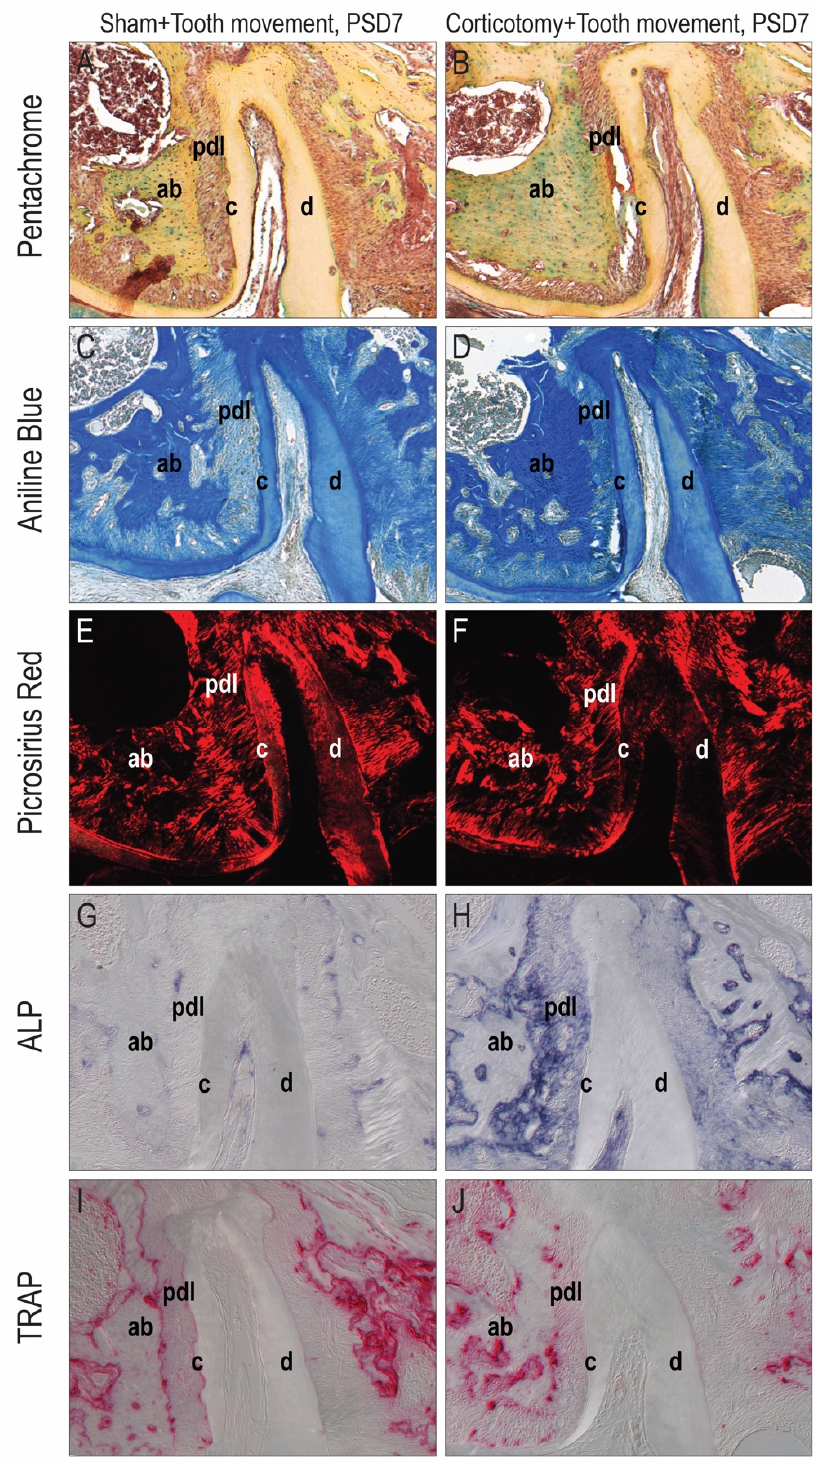
Figure 4. Histological sections from the distal roots of the maxillary first molar on PSD 7 ( n = 12). ( A ) Tissue sections stained with Movat’s pentachrome after Sham + TM and ( B ) Corti+TM. ( C ) Aniline blue staining after Sham + TM and ( D ) Corti + TM. ( E ) Tissues stained with picrosirius red after Sham + TM and ( F ) Corti + TM. ( G ) Tissue sections stained with ALP to detect mineralized activity after Sham + TM and ( H ) Corti + TM. ( I ) Tissue sections stained with TRAP to detect osteoclast activity after Sham + TM and ( J ) Corti + TM. Abbreviations: PSD: post-surgery day. M: mesial. D: distal. pdl: periodontal ligament. ab: alveolar bone. d: dentin. c: cementum. Scale bar = 50 um for all panels.